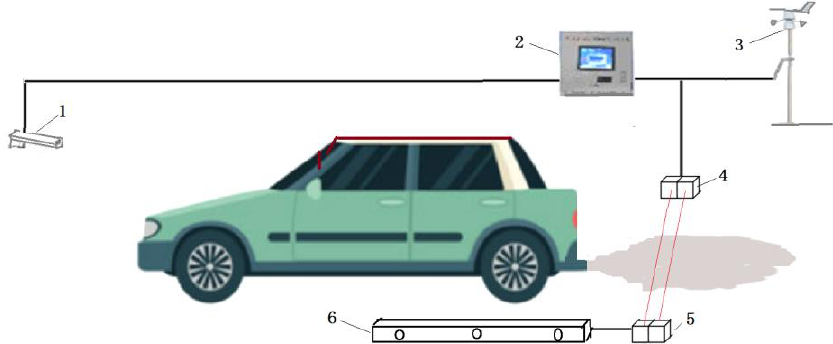
Figure 1. Schematic of vehicle emission remote sensing system. 1. License plate camera; 2. main control computer; 3. weather station; 4. light source and detector; 5. reflector; 6. speedometer.